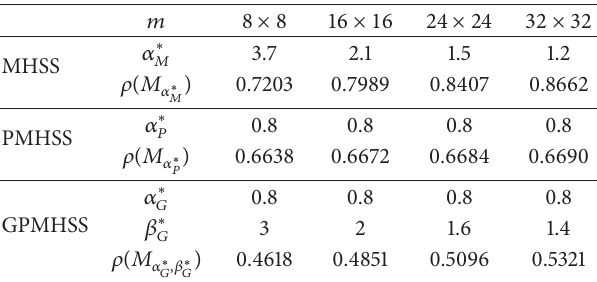
Table 1: The experimentally optimal parameters and the spectral radii for the iteration matrices of MHSS, PMHSS, and GPMHSS with 𝑃 = 𝑃 1 = 𝑃 2 = 𝑊